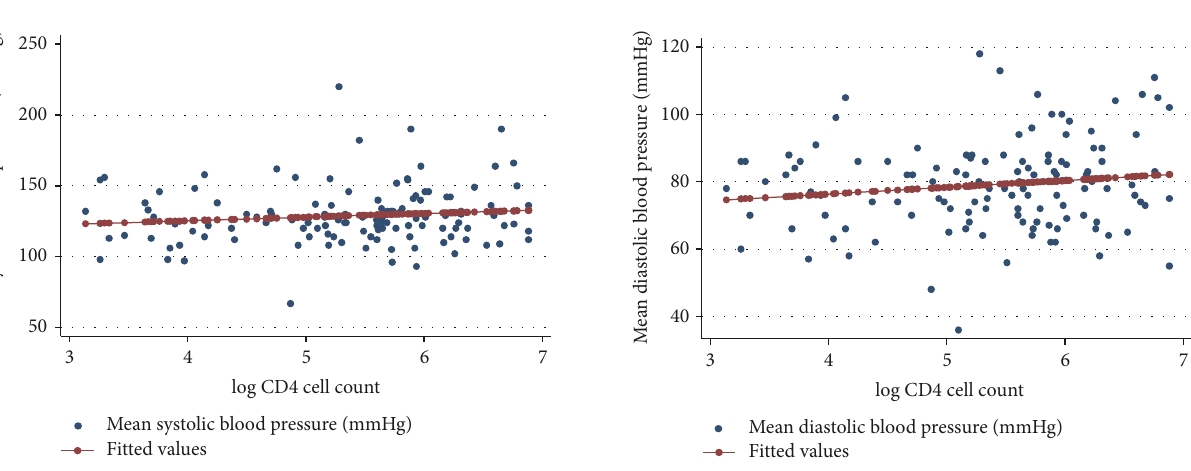
∗ Odds ratio adjusting for all variables on the table; ∗∗ 𝑝 values for the Wald test statistic. BMI: body mass index, HAART: highly active antiretroviral therapy, and HTN: hypertension.